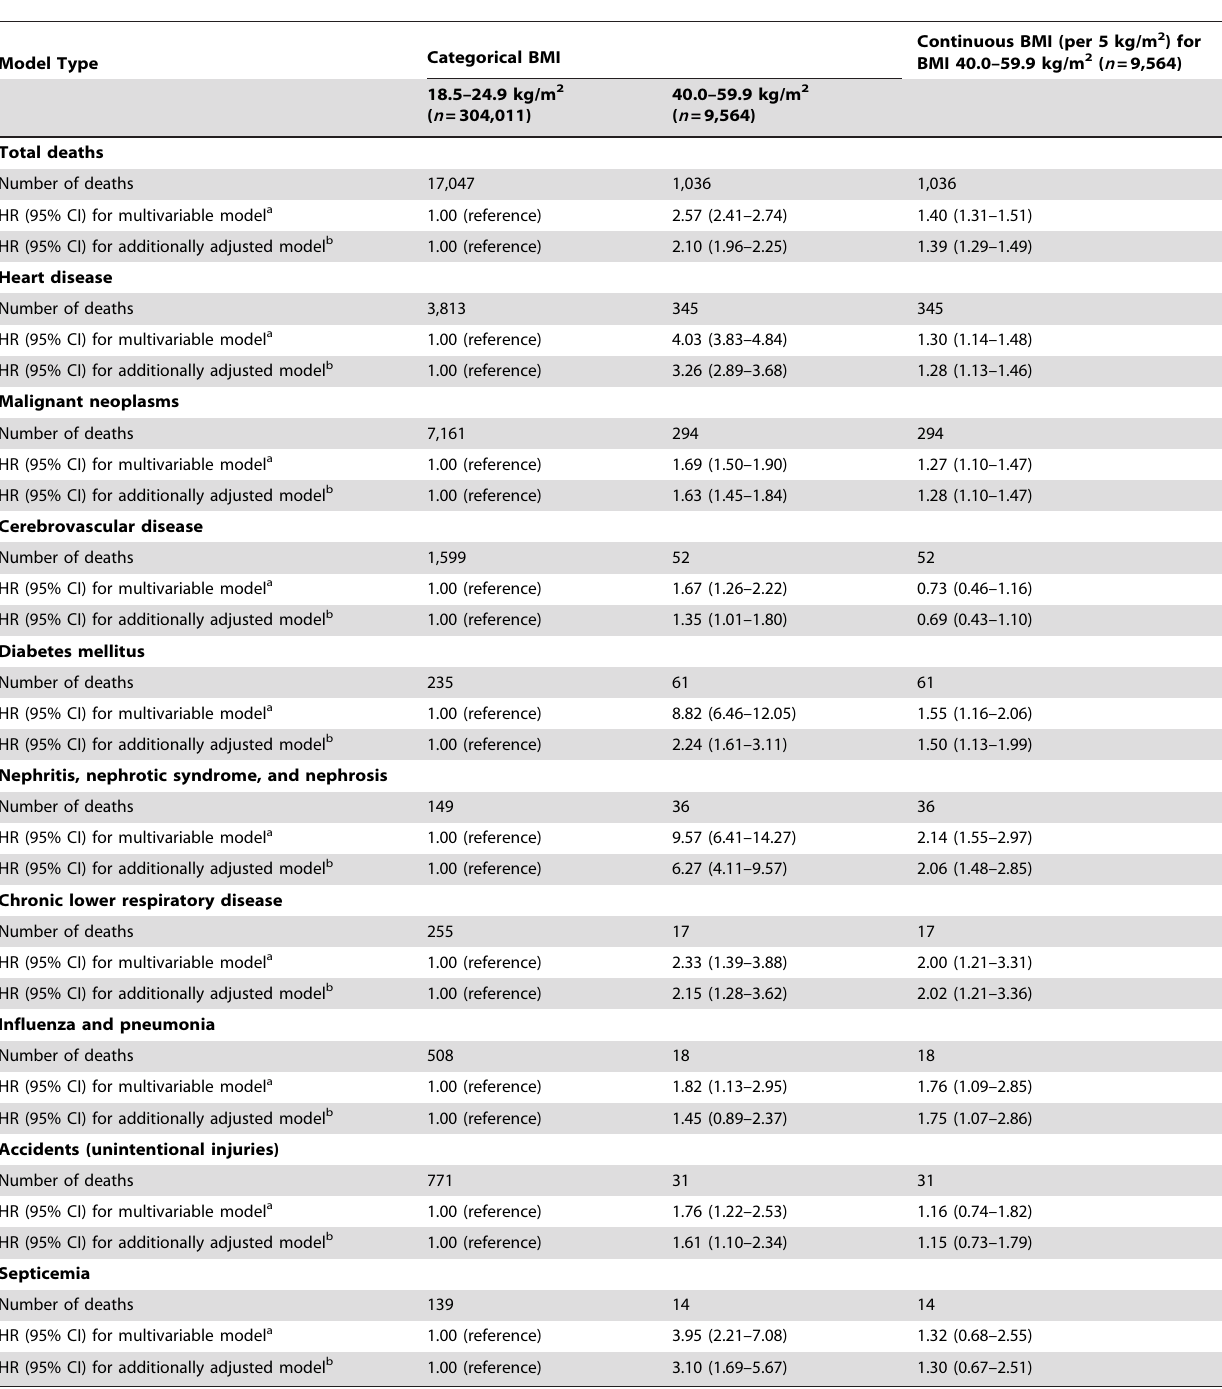
Table 6. Hazard ratios and 95% confidence intervals for select major causes of death by BMI